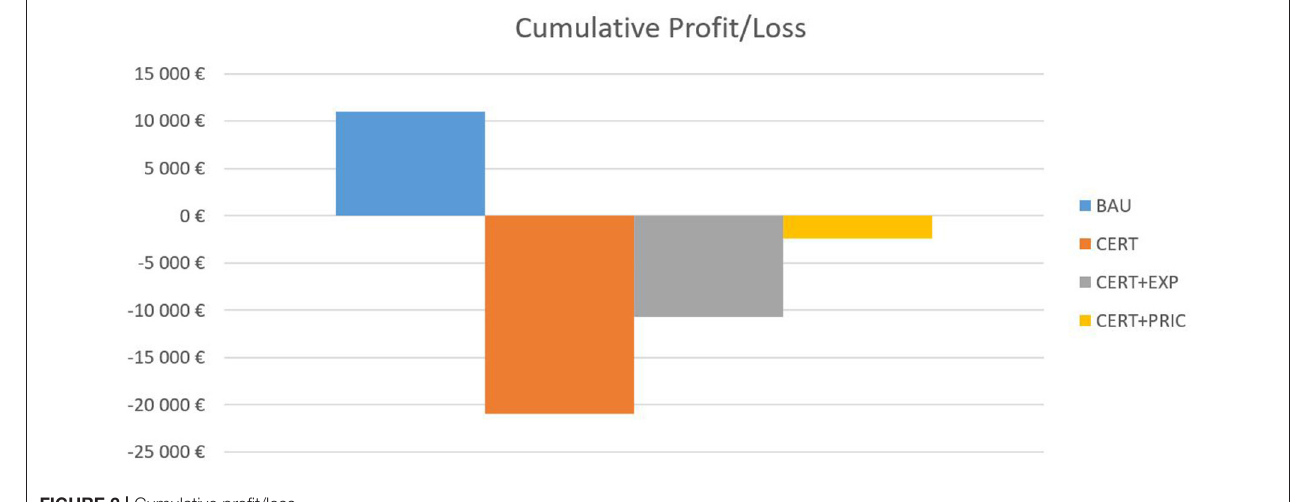
FIGURE 2 | Cumulative profit/loss.